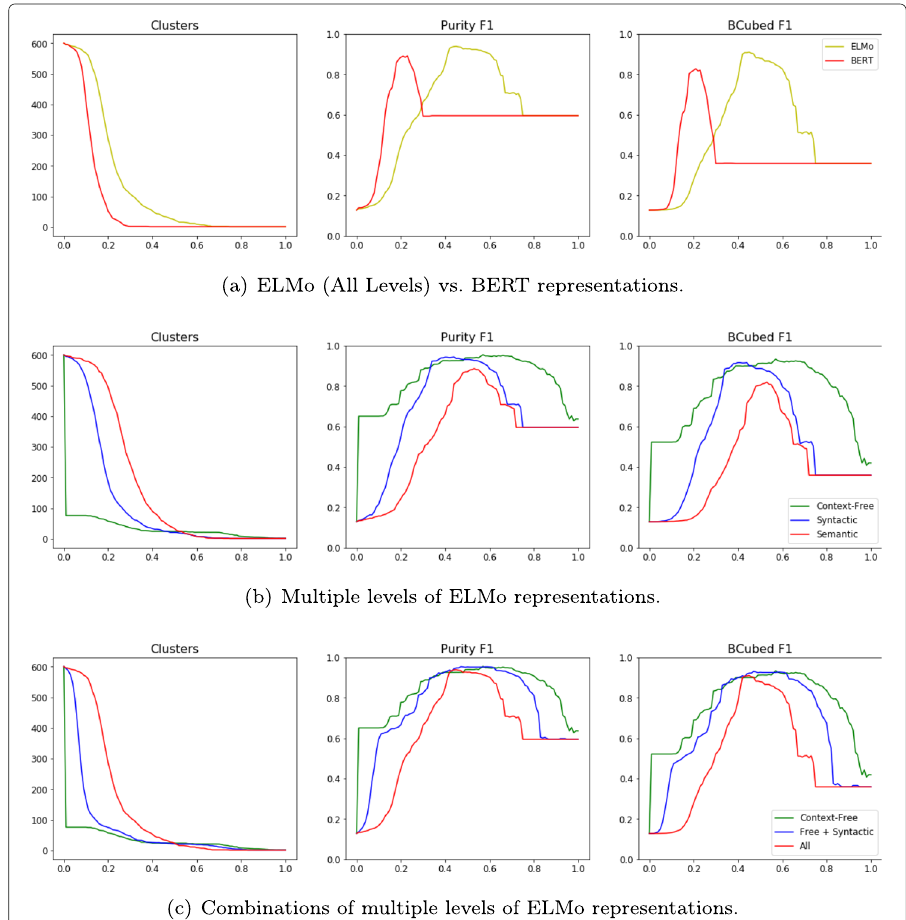
Fig. 1 Semantic frame induction results achieved using different contextualized representations of verb instances. The horizontal axes refer to the neighboring threshold used to create the edges